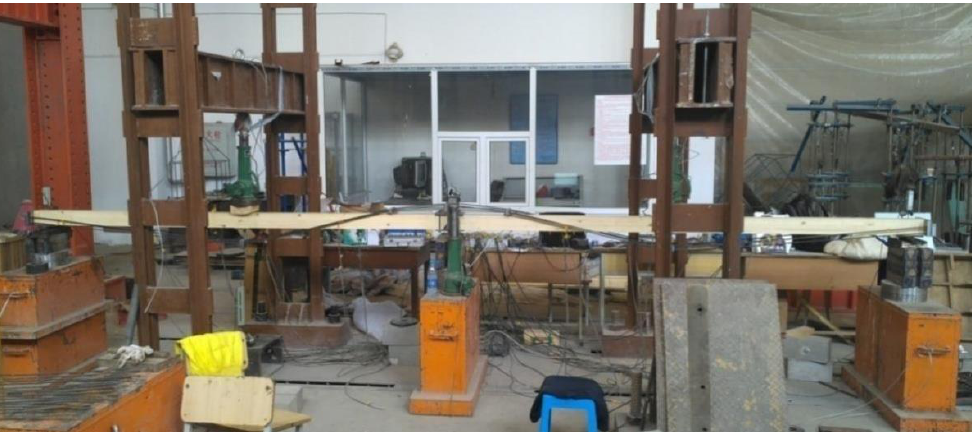
Figure 4. Prestressed glulam continuous beam.